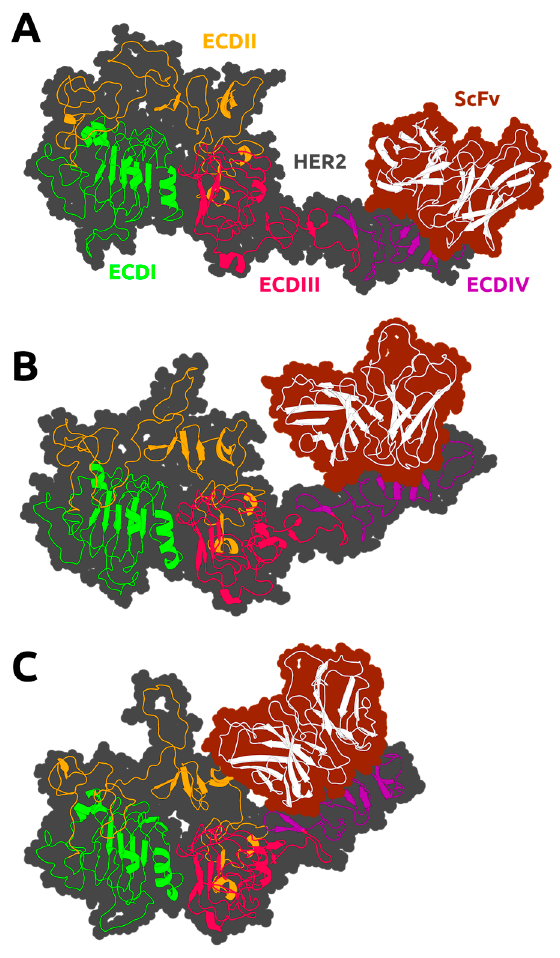
Figure 3. Snapshots of the ScFv:HER2 system in open ( A ), intermediate ( B ), and closed ( C ) conformations. The secondary structure of the receptor and its partners is depicted as a cartoon, and the surface is shown as a contour.